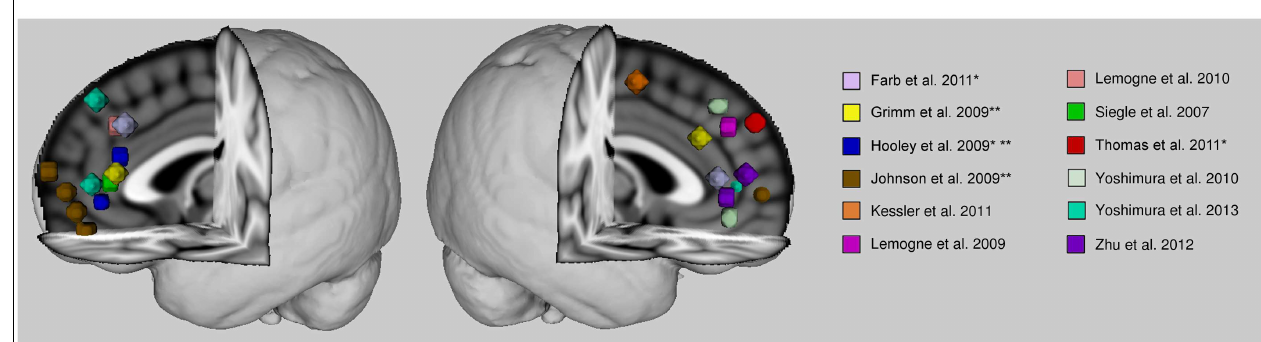
face processing) where activity was associated with rumination scores. Talairach coordinates were converted into MNI space with BrainMap toolbox (brainmap.org). Activity is greater in patients than control subjects unless otherwise indicated. *With a remitted patient sample. **Hypoactivity in